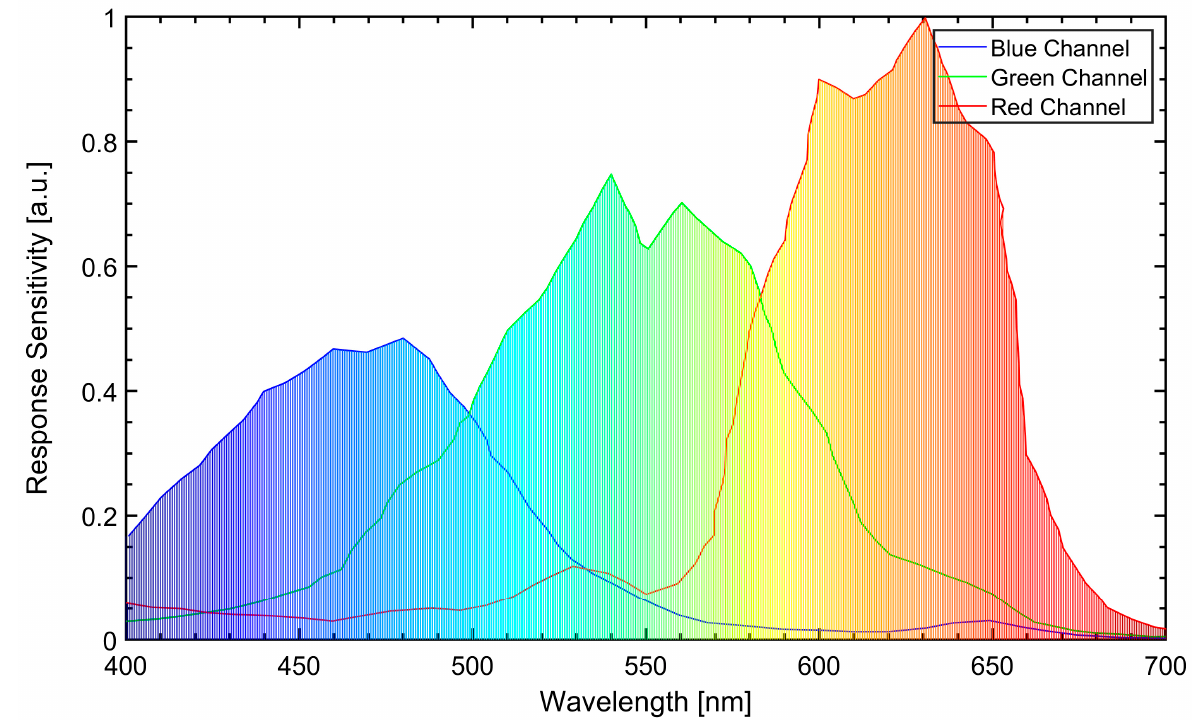
Figure 2. Relative spectral response curves of Photron SA-Z color camera.